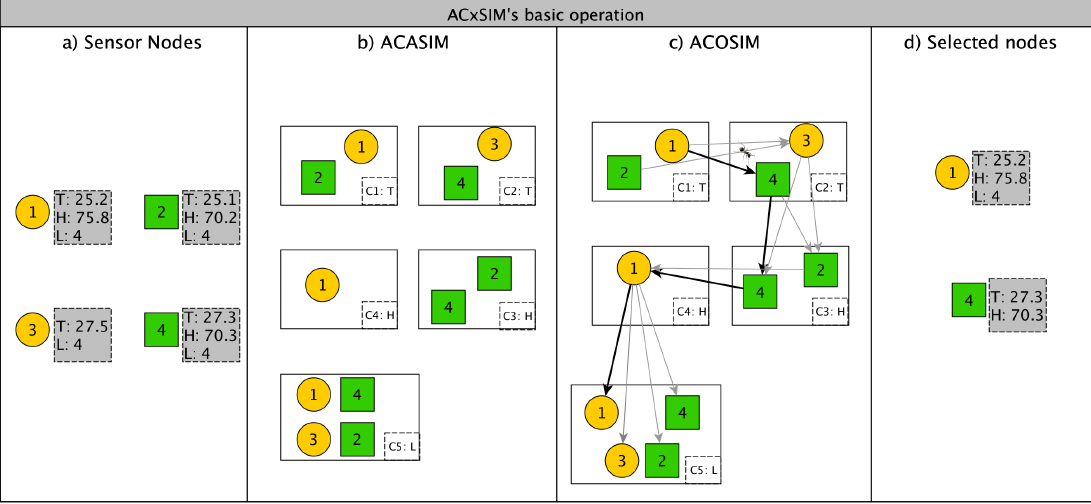
Figure 4. ACxSIMv2’s basic